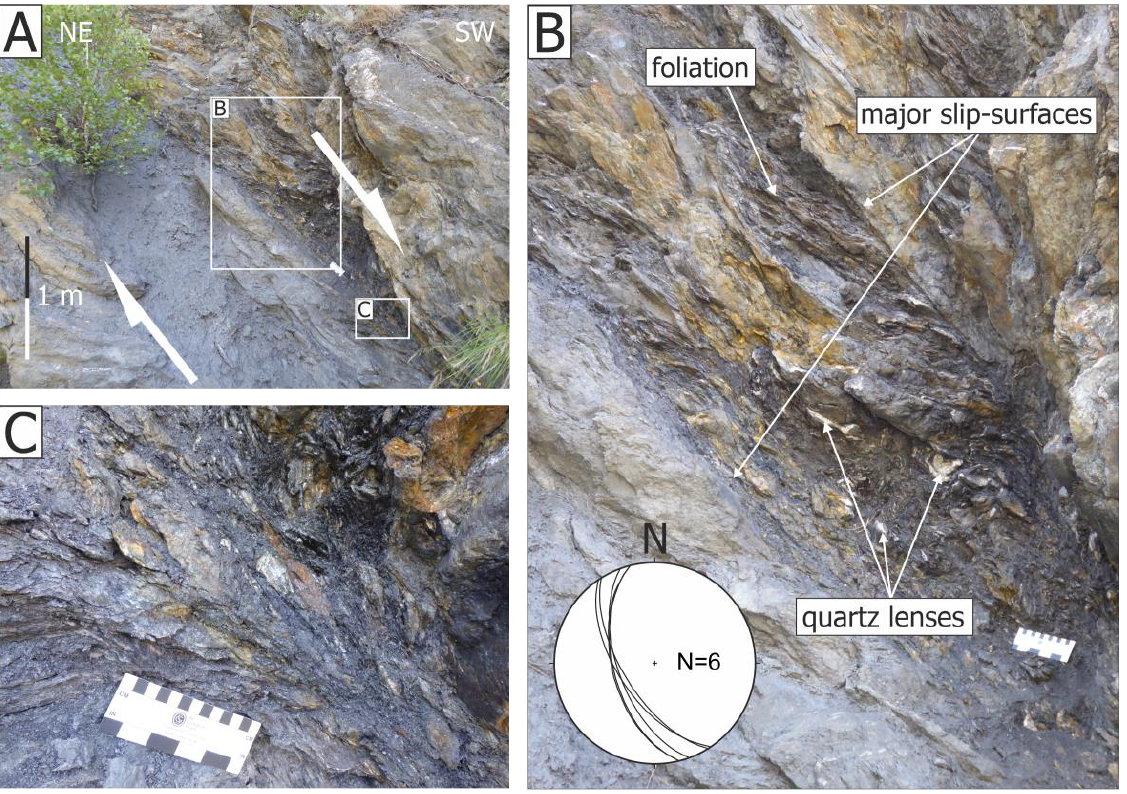
Figure 2. Photographs of the outcrop. ( A ) Picture of the outcrop, showing the thickness of the fault gouge and the macrostructure; ( B ) detail of the internal foliation (insert: stereographic projection of the slip planes); ( C ) the contact of the internal foliation with the wall of the fault core.